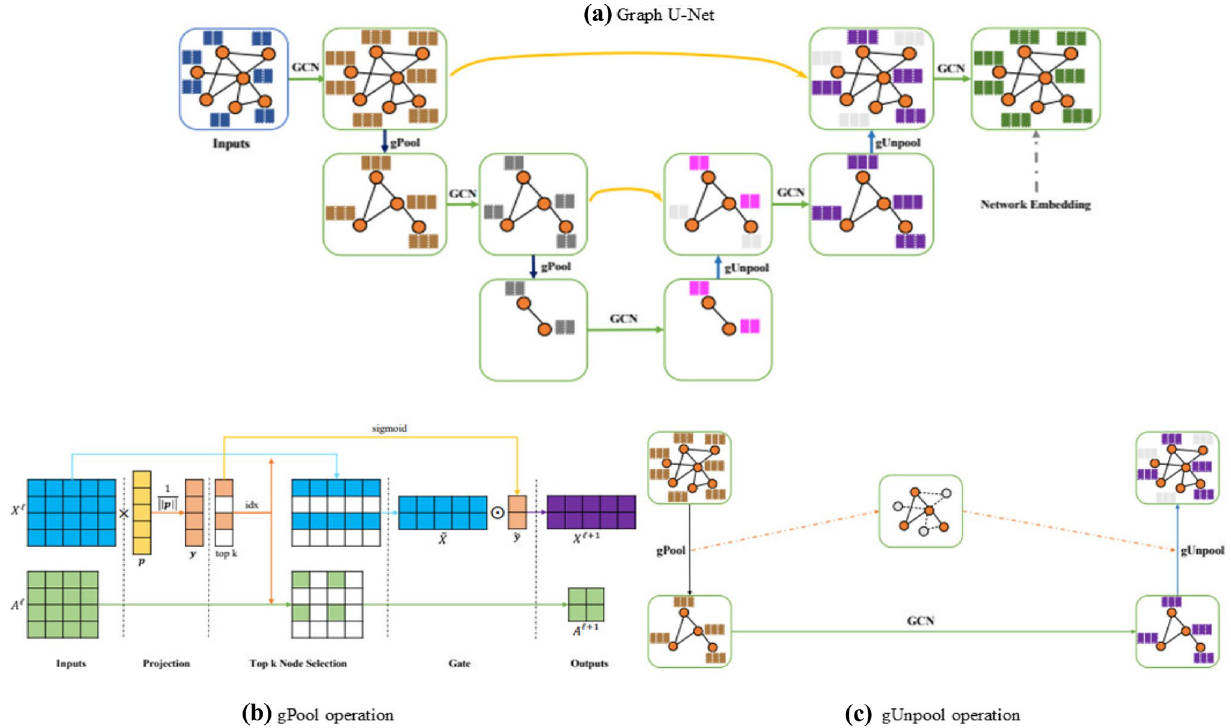
Fig. 2 An illustration of the graph U-Net architecture and its encoder–decoder parts. a In this example, each node in the input graph has 2 features for node classification task. It has 2 encoding/decoding blocks and 2 skip-connections. b The graph pooling layer considers the situation of a graph with 4 nodes, and each node has 5 features. After pool with 0.5 pooling ratio, the coarsened graph has 2 nodes. c For example, a graph with 7 nodes is down-sampled, resulting in a coarsened graph with 4 nodes and position information of selected nodes. The corresponding gUnpool layer uses the position information to reconstruct the original graph structure by distributing empty feature vectors to unselected